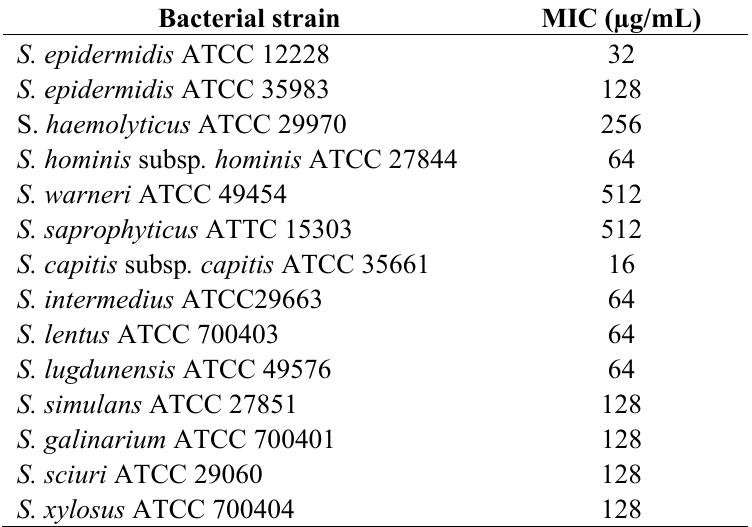
Table 1. MIC (expressed in µg/mL) of berberine against fourteen CoNS